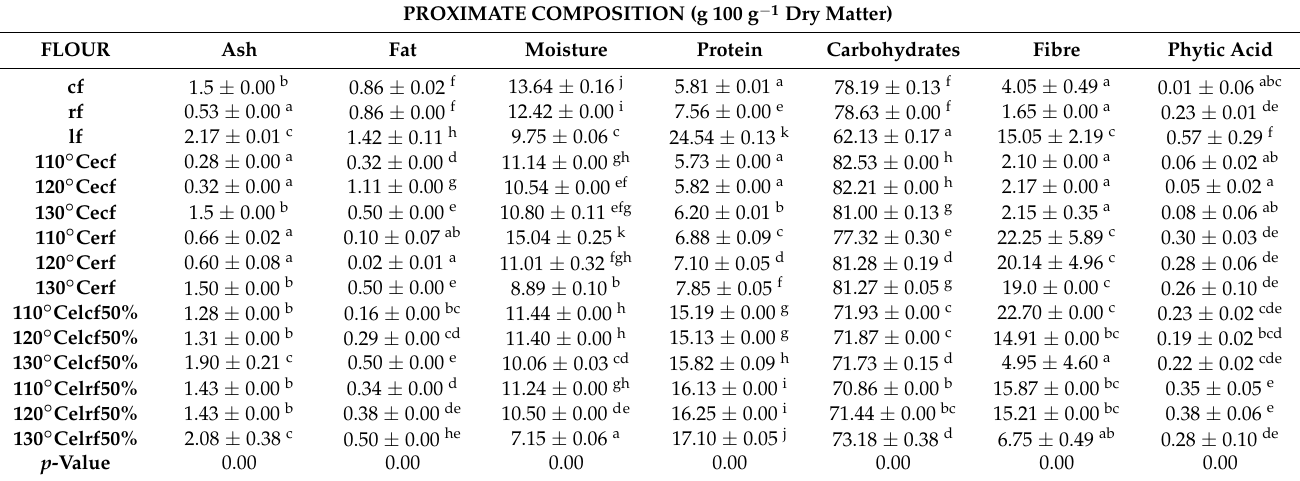
Table 1. Proximal composition (g 100 g − 1 ) of native and extruded